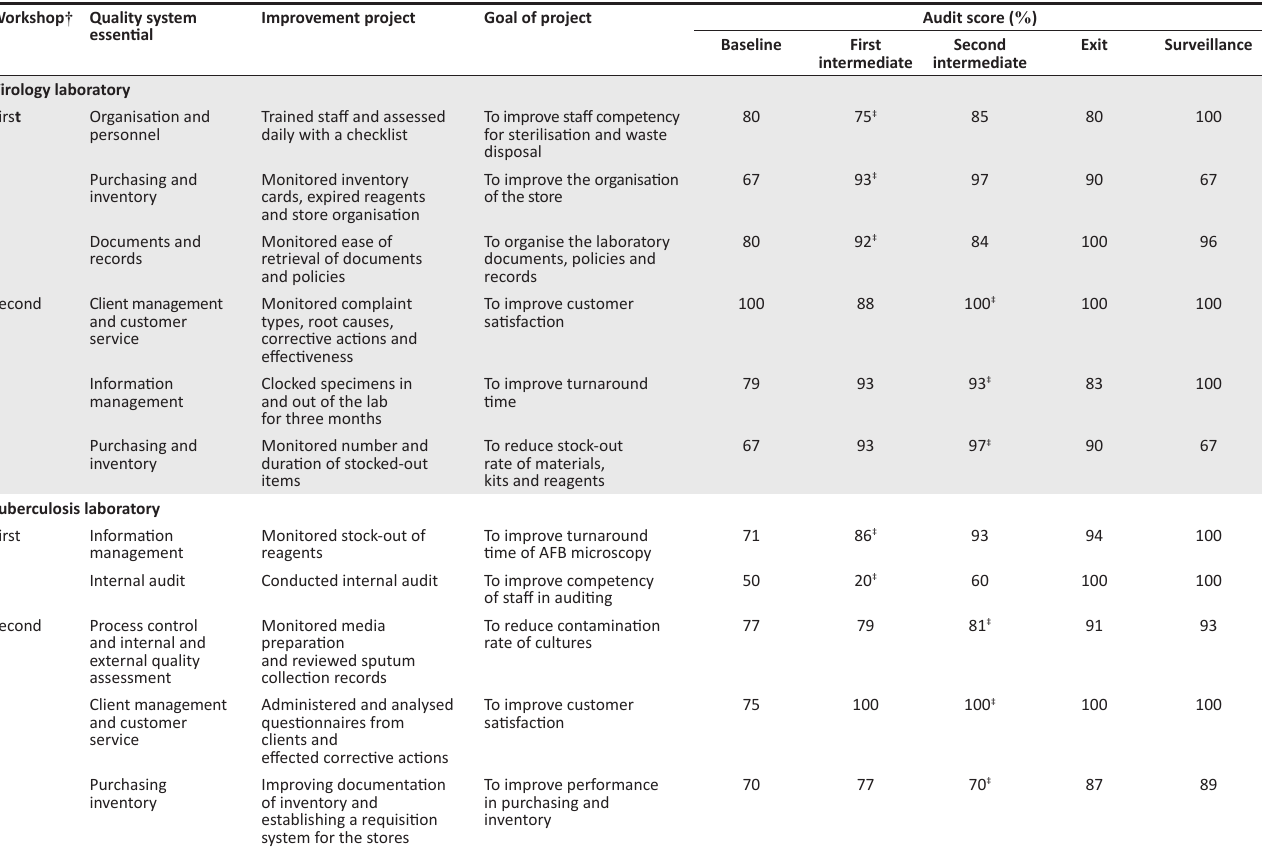
TABLE 1: Impact of quality improvement projects on quality system essentials in the virology and tuberculosis laboratories of the Nigerian Institute of Medical Research. Workshop † Quality system